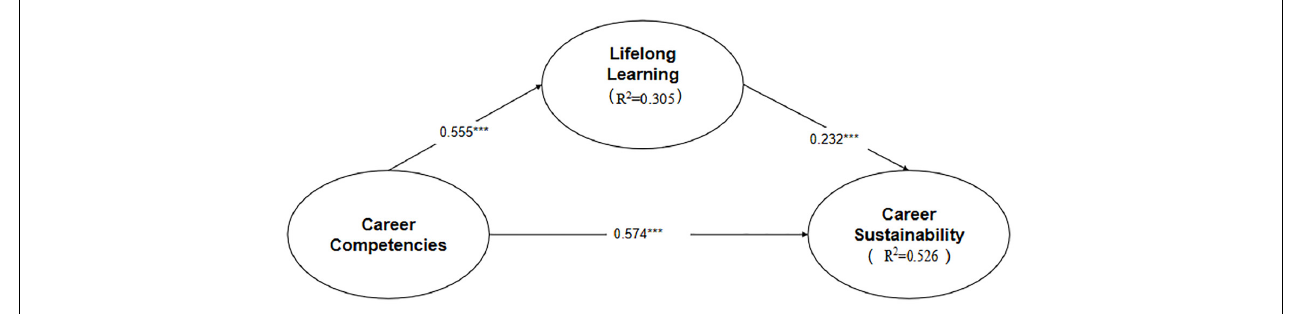
FIGURE 2 | PLS results outcomes. *** t =